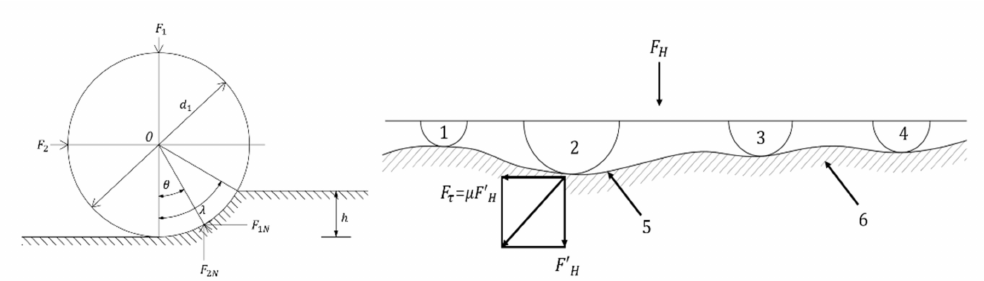
Figure 4. Schematic diagram of the bit and interacting with the bedrock